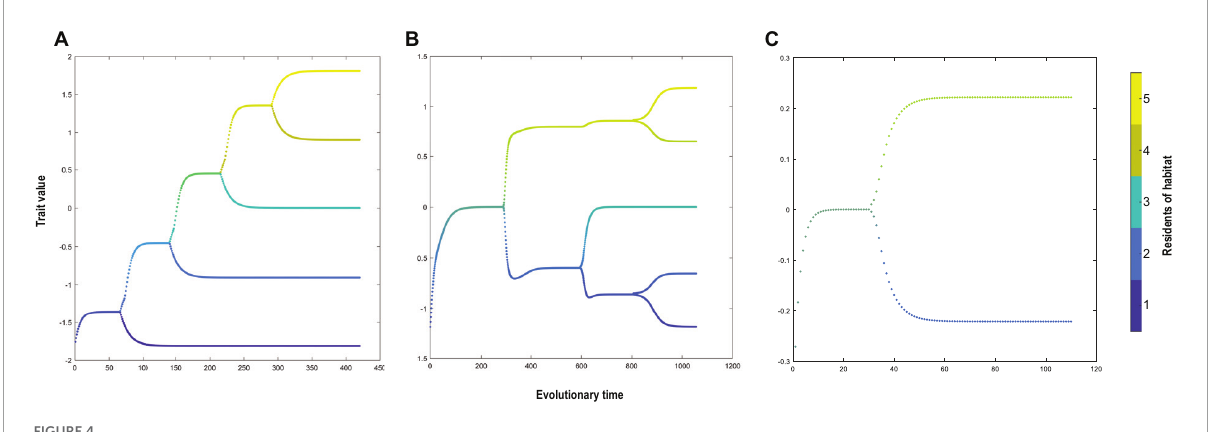
FIGURE4 The evolutionary trajectory under (A) environmental gradient ( (cid:49) u opt ) = 0 . 9 σ u with dispersal probability d = 10 − 5 and (B) environmental gradient ( (cid:49) u opt ) = 0 . 6 σ u with dispersal probability d = 0.07 and (C) environmental gradient ( (cid:49) u opt ) = 0 . 19 σ u with dispersal probability d = 0.04. The horizontal axis indicates the evolutionary time throughout the simulation, and the vertical axis indicates the population trait value. At each evolutionary time, each species is mapped as a dot with the color representing the proportional distribution among